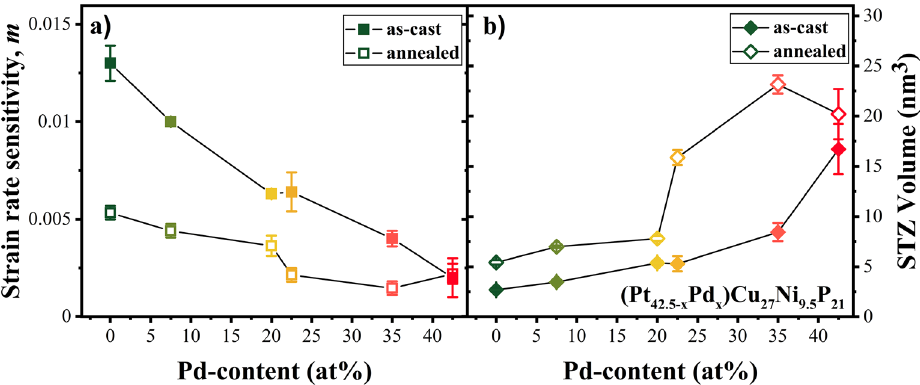
Figure 3. ( a ) Strain rate sensitivity, m, as a function of Pd content for the as-cast and annealed state obtained from linear fitting of hardness versus logarithm of strain rate (shown in Supplementary Information Fig. S1); ( b ) STZ volume versus Pd concentration for as-cast and annealed state, showing the lowest STZ volume for Pt 42.5 Pd 0 alloy supporting its more homogeneous plastic